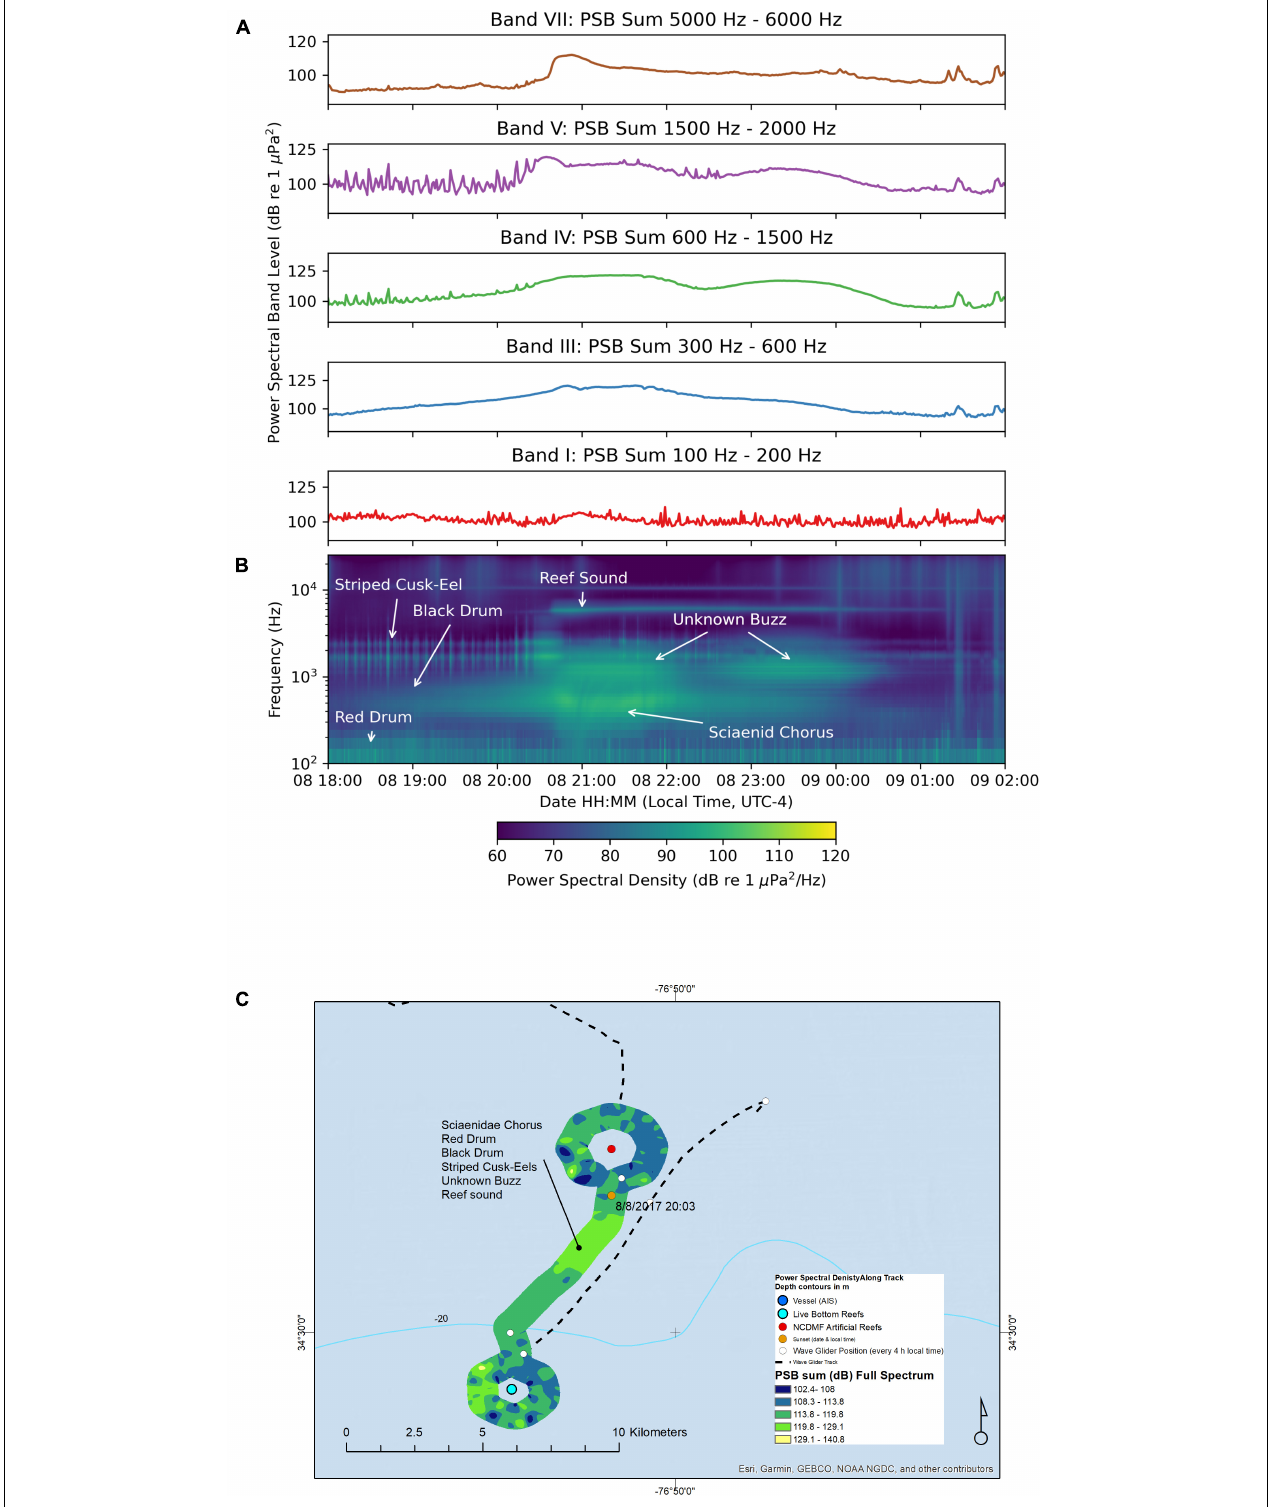
FIGURE 8 | Sound recorded by the wave glider Blackbeard between August-08 18:00 and August-09 02:00. (A) Power spectral band sums for 60 s windows of the recording. (B) Composite spectrogram produced from 60 s average power spectral densities. (C) Map of the path of the wave glider during the recording. The color of the path indicates the full spectrum PSB sum detected at the